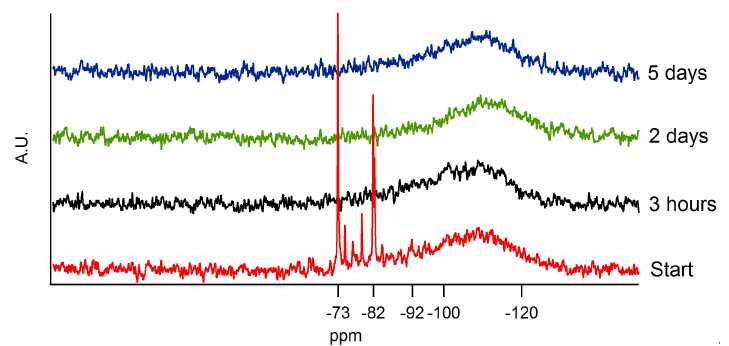
Figure 5. NMR spectrogram of the sol at different time intervals.